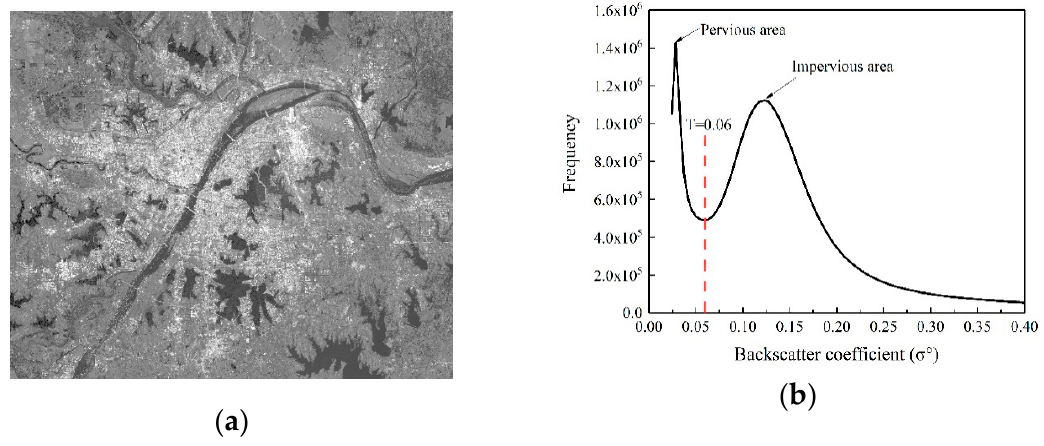
Figure 3. ( a ) Example of different land covers in synthetic aperture radar (SAR) image; ( b ) the corresponding histogram .